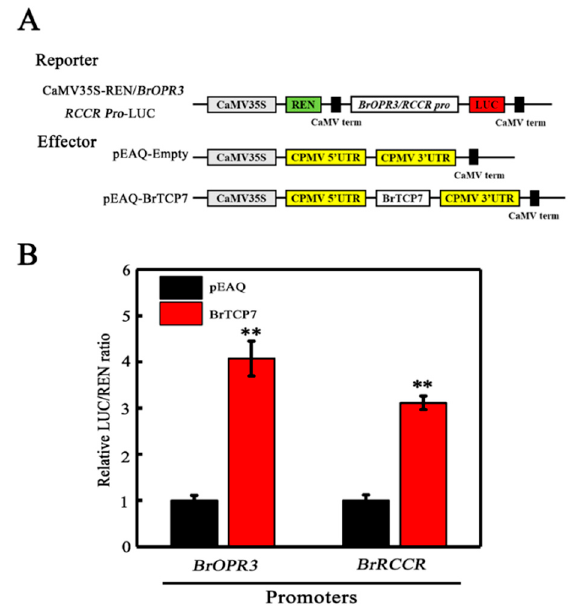
Figure5. BrTCP7enhances BrOPR3 and BrRCCR Figure 5. BrTCP7 enhances BrOPR3 and BrRCCR transcriptions by transient transcription dual- luciferase assay in Nicotiana benthamiana leaves. ( A ) Diagrams of the reporter and effector vectors. ( B )